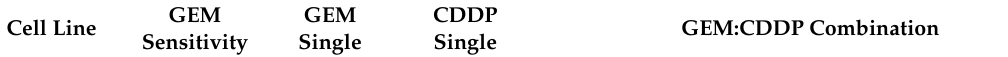
Table 2. IC50 values and the e ff ects of combination GC chemotherapy based on the Bliss index and the combination